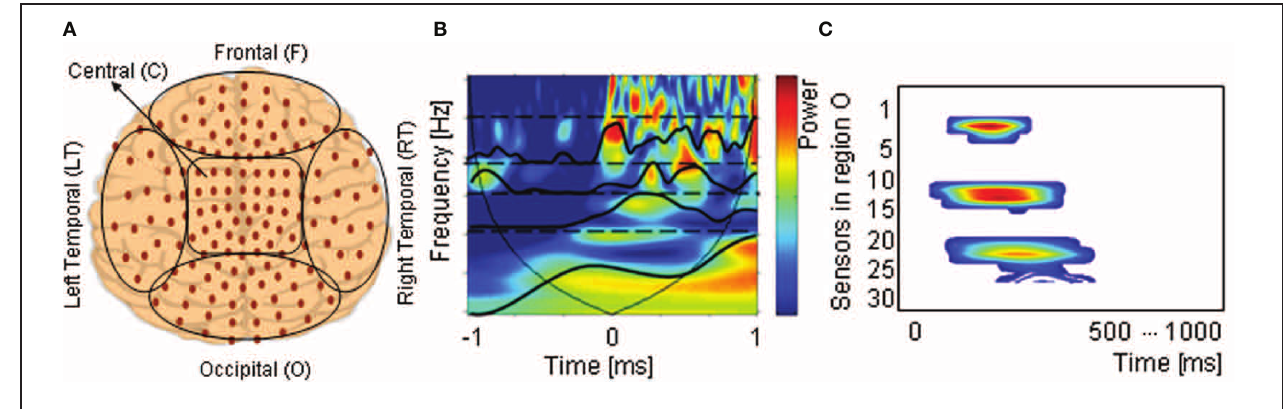
FIGURE 3 | (A) The five defined brain regions: Frontal (F), Central (C), Occipital (O), and Left and Right Temporal (LT, RT) areas. (B) Time-Frequency representation of one sensor from 1s before to 1s after stimulus onset. Frequency scales are averaged in standard